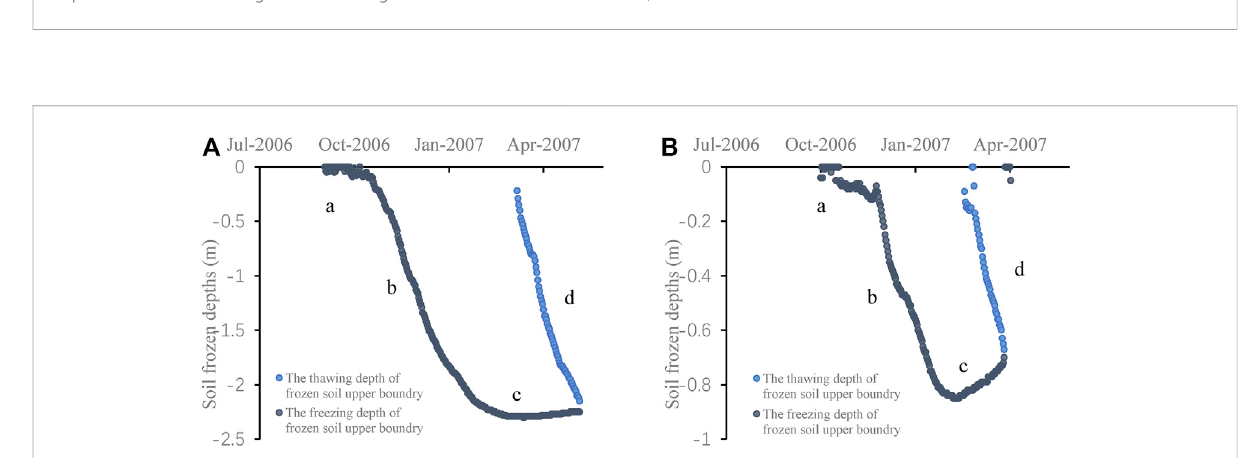
FIGURE 3 The processes of frozen soil freezing and thawing at Maduo station (A) and Jiuzhi station (B) from 1 July 2006 to 30 June